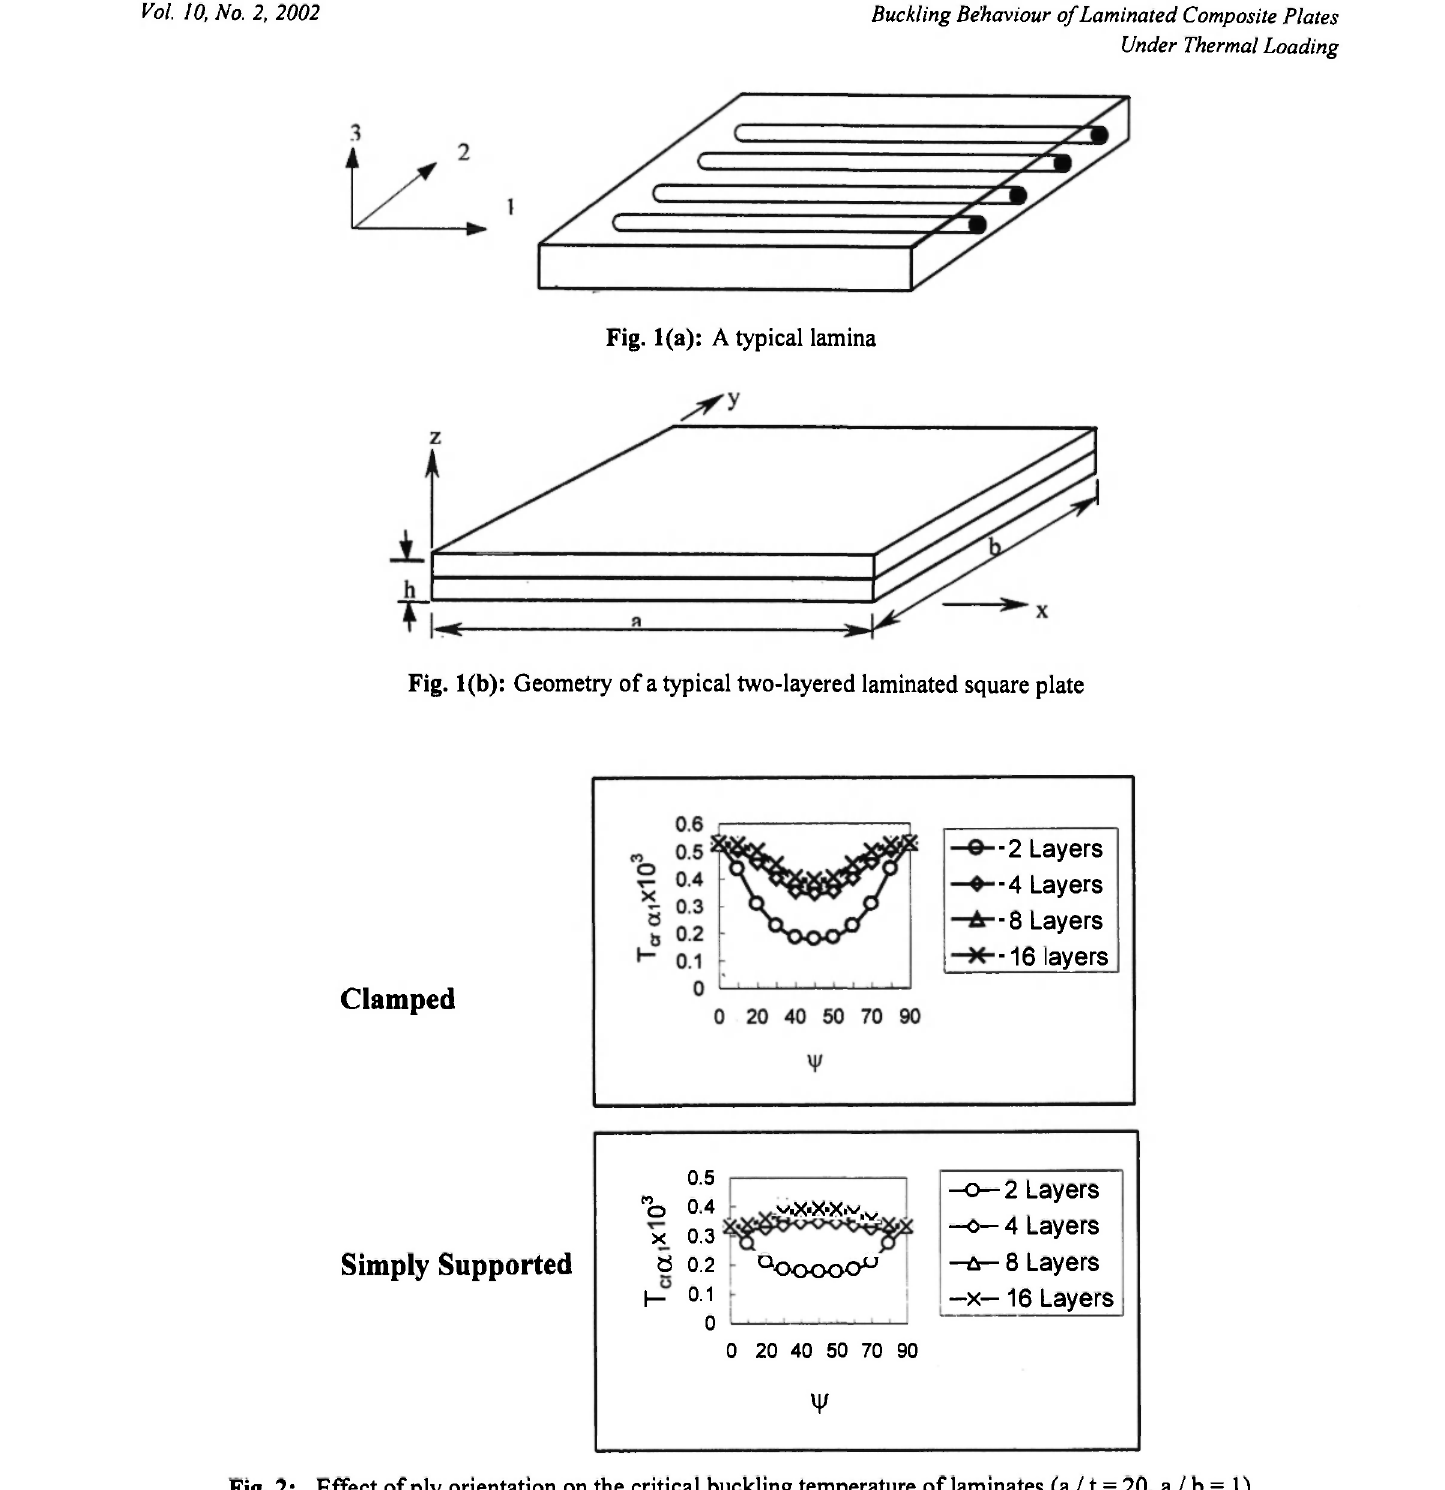
Fig. 2: Effect of ply orientation on the critical buckling temperature of laminates (a /1 = 20, a / b = 1) However, the reverse phenomenon is observed in two- layer laminates. This is because bending-stretching coupling stiffness reach their maximum values at stacking layers N=2 and decrease rapidly as Ν increases.